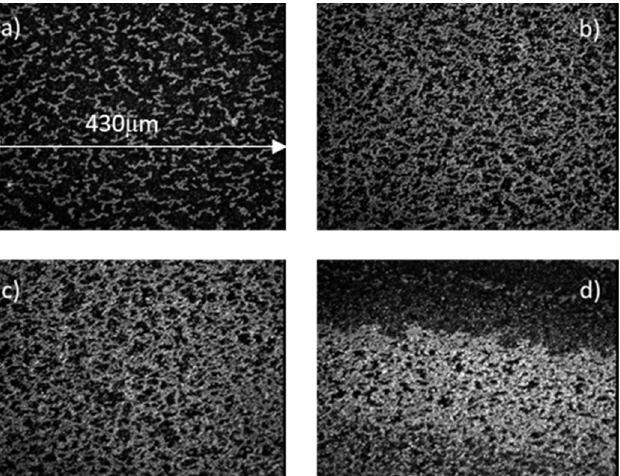
Figure 3. BAM images of TbPc 2 (OC 11 H 21 ) 8 recorded at different surface pressure values, 4 mN · m − 1 (box a), 7.5, 18 and 29 mN m − 1 (boxes b – d ). Width of images is 430 μ m.